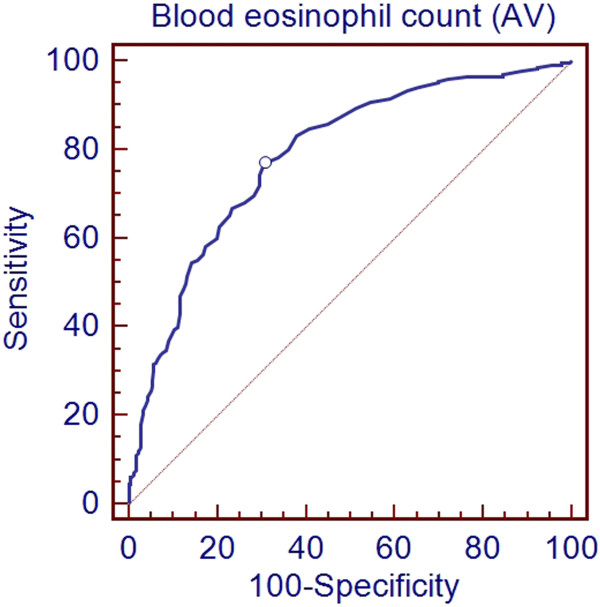
Receiver-operating characteristic (ROC) curve for the whole group to determine the blood eosinophil count value that best identified a sputum eosinophilia ≥3%. The optimum cut-off point was 220/mm3 (Sensitivity 77%, specificity: 70%, AUC: 0.790, p < 0.0001).